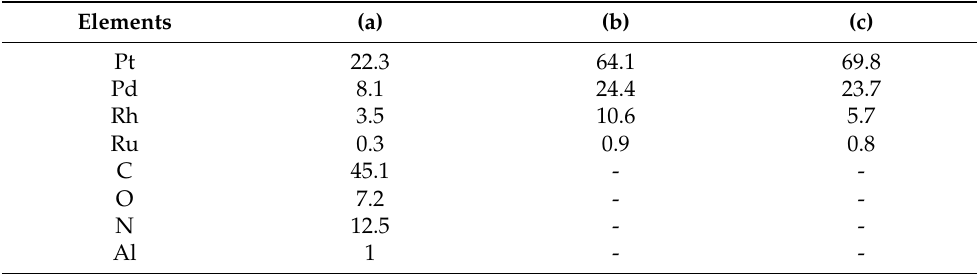
Table 2. Concentrations (at.%) of all the detected elements (a) and values calculated after exclusion of C, O, N and Al (b) in the subsurface layer on the frontal side of the Pt–Pd–Rh–Ru gauze used in NH 3 oxidation according to EDS measurements. (c) The content of metals in the gauzes according to the manufacturer